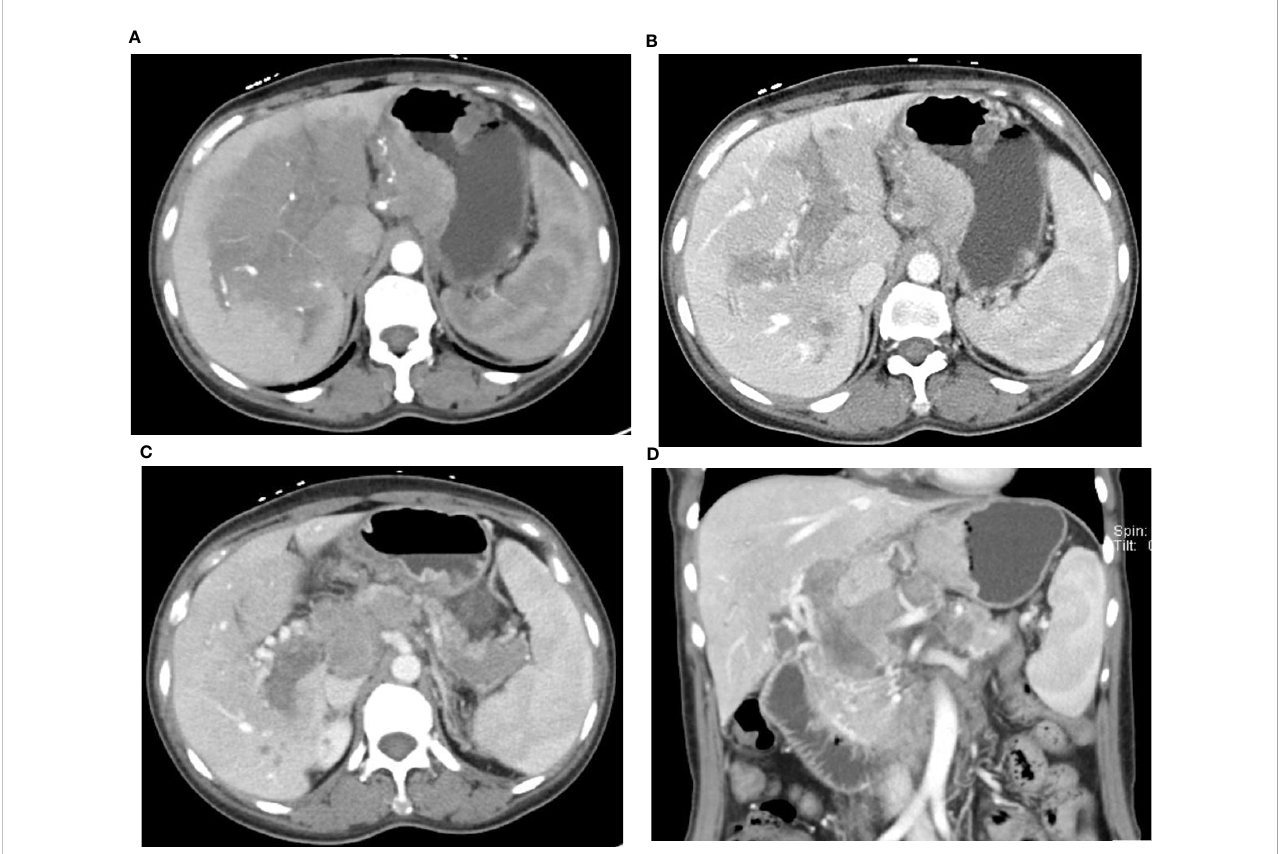
FIGURE 4 49-year-old woman with HAS and portal vein tumor thrombus. AFP: 777.30 IU/ml. The mass at the lesser gastric curvature shows mild-to-moderate enhancement in the arterial phase (A) and venous phase (B) . Large area of low density in the hilar parenchyma with arterial phase enhancement lower than normal parenchyma. Tumor thrombus in the portal vein and splenic vein, Collateral circulation formed around the portal vein (C, D) , Multiple LN metastasis in the perigastric area, behind the hepatic hilum — the head of pancreas, and the retroperitoneal area (C, D)